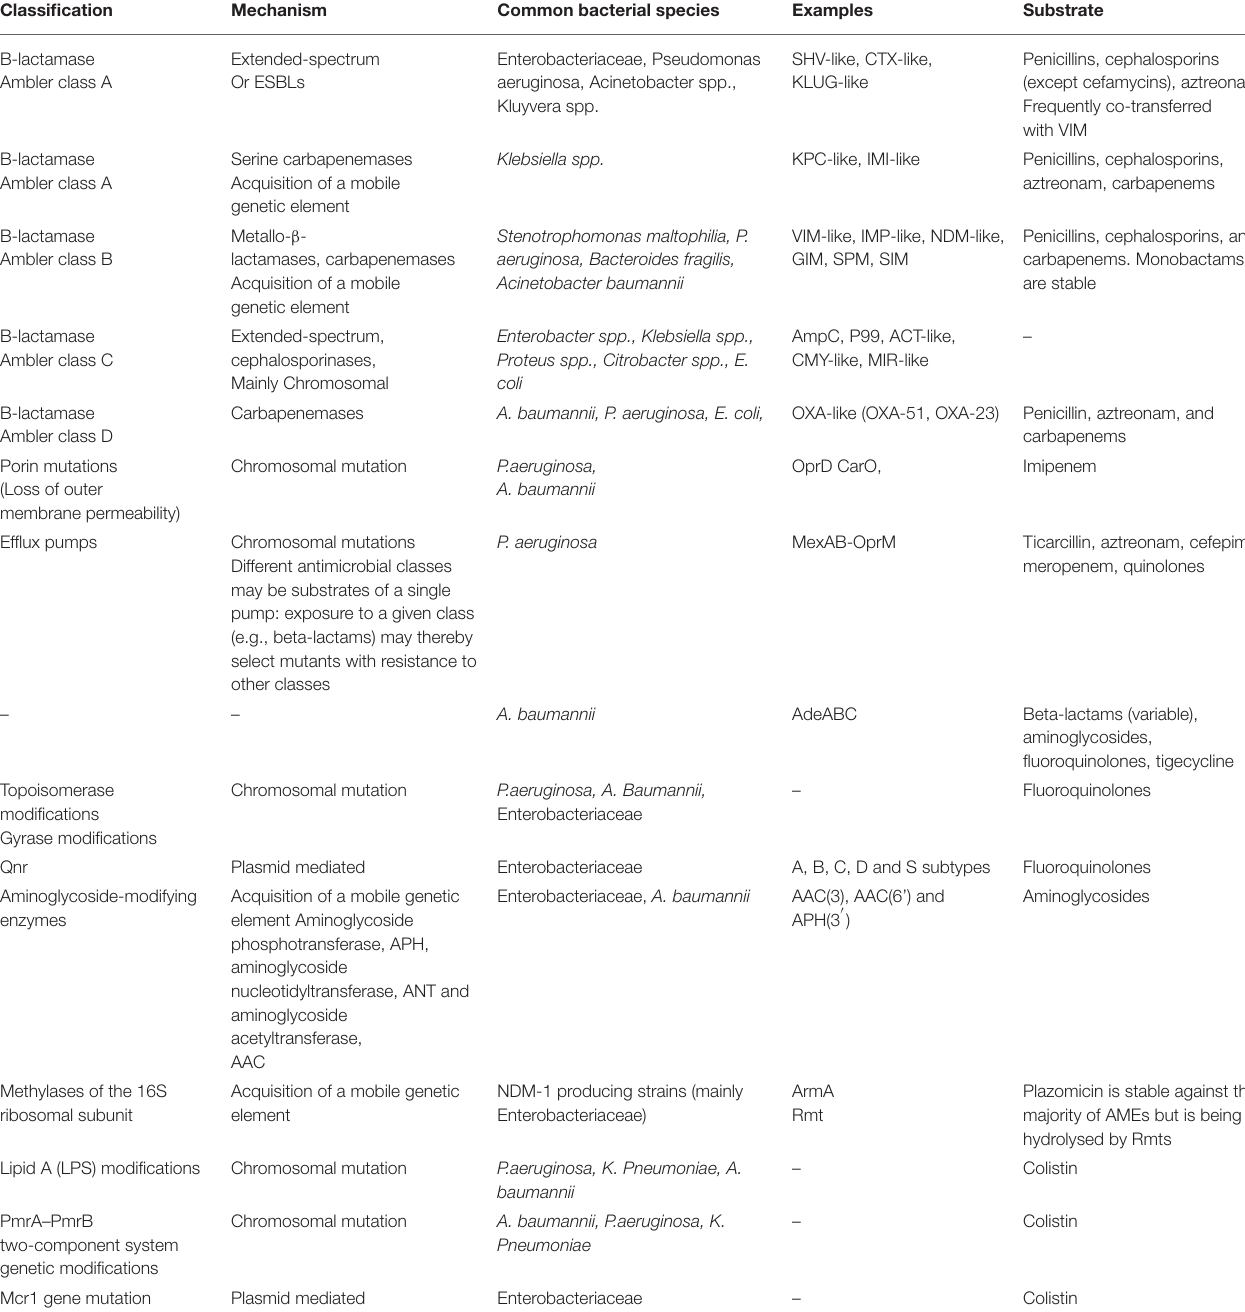
TABLE 1 | Prevalent mechanisms of resistance among pathogens with extended-drug resistance (XDR)